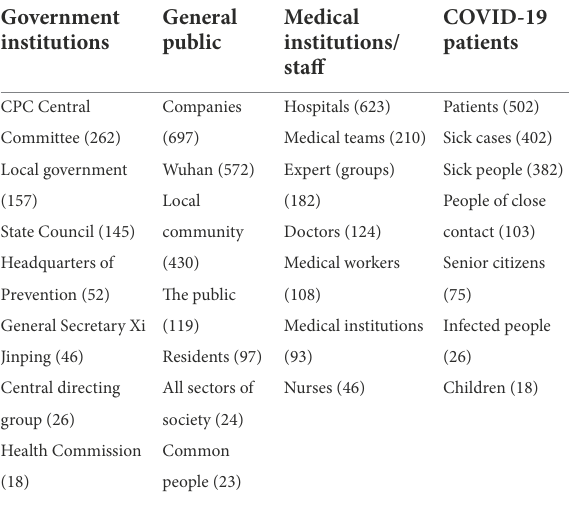
TABLE 2 Social actors identified in press conferences on COVID-19 in